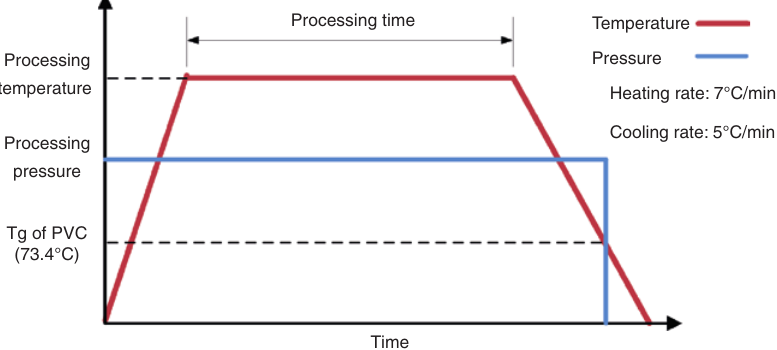
Figure 2: Processing pressure and temperature cycle of the production process (heating rate is 7 ° C/min and cooling rate is 5 ° C/min).